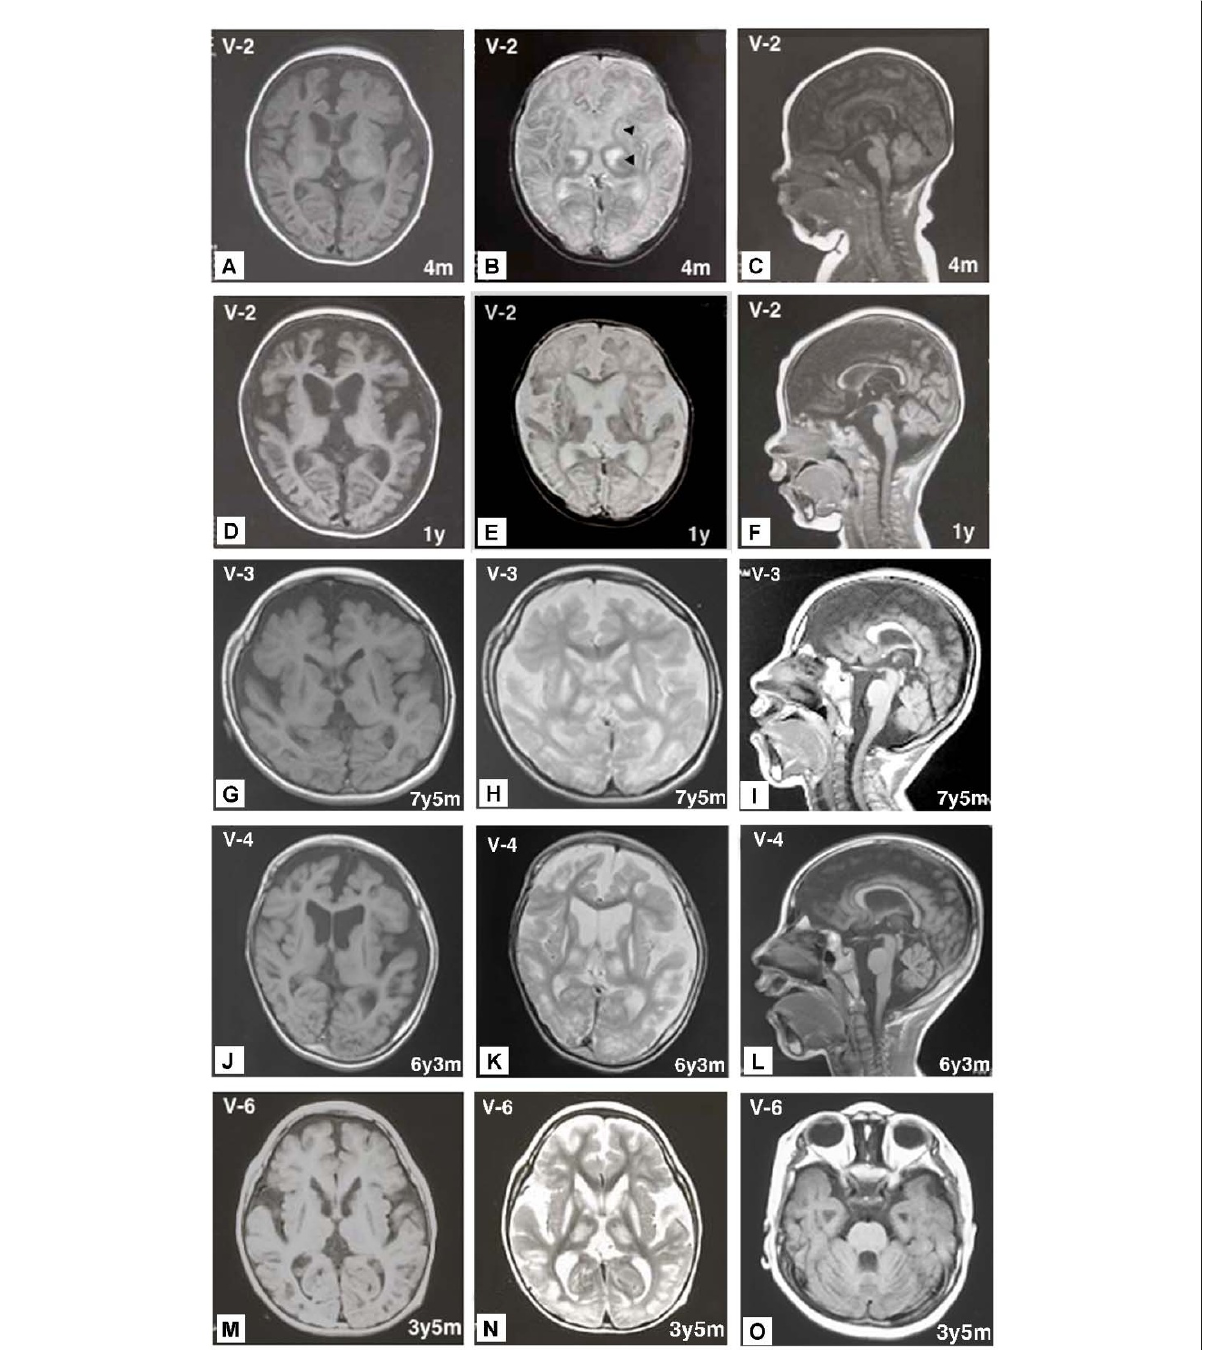
Figure 2 MRIs of patients V-2, V-3, V-4 and V-6 at various ages . Areas of abnormal intensity in the thalami and basal ganglia (arrowheads) were distinct at 4 months in V-2 (A, B). The sagittal and axial views of T1- and T2-weighted images of V-2 at 1 year showed severe brain atrophy (D, E, F). The sagittal and axial views of T1- and T2-weighted images of V-3 at 7 years, 5 months (G, H, I), V-4 at 6 years, 3 months (J, K, L), and V-6 at 3 years, 5 months (M, N, O) showed severe brain atrophy, including cerebellar atrophy (I, L, O) and abnormal intensity areas in the thalami and basal